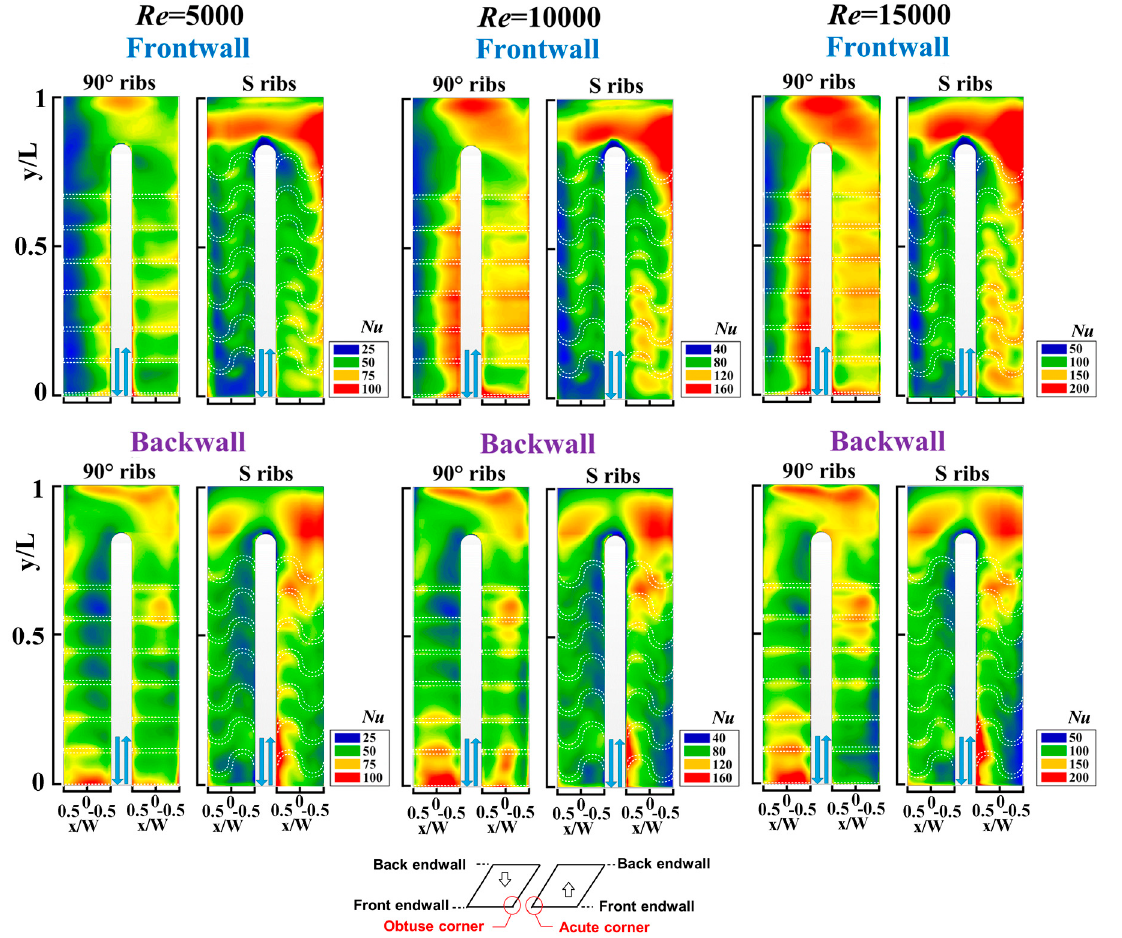
Figure 2. Detailed Nusselt number distributions on front and back endwalls of the twin-pass parallelogram channels with detached transverse and S-ribs at Reynolds numbers of 5000, 10,000, 15,000. The high Nusselt number regions constantly develop along the endwall edge adjoining the obtuse corners of the parallelogram channels for both front and back endwalls.